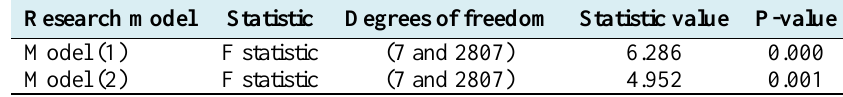
Table 5. The results of the Breusch-Pagan-Godfrey testing of the BSE